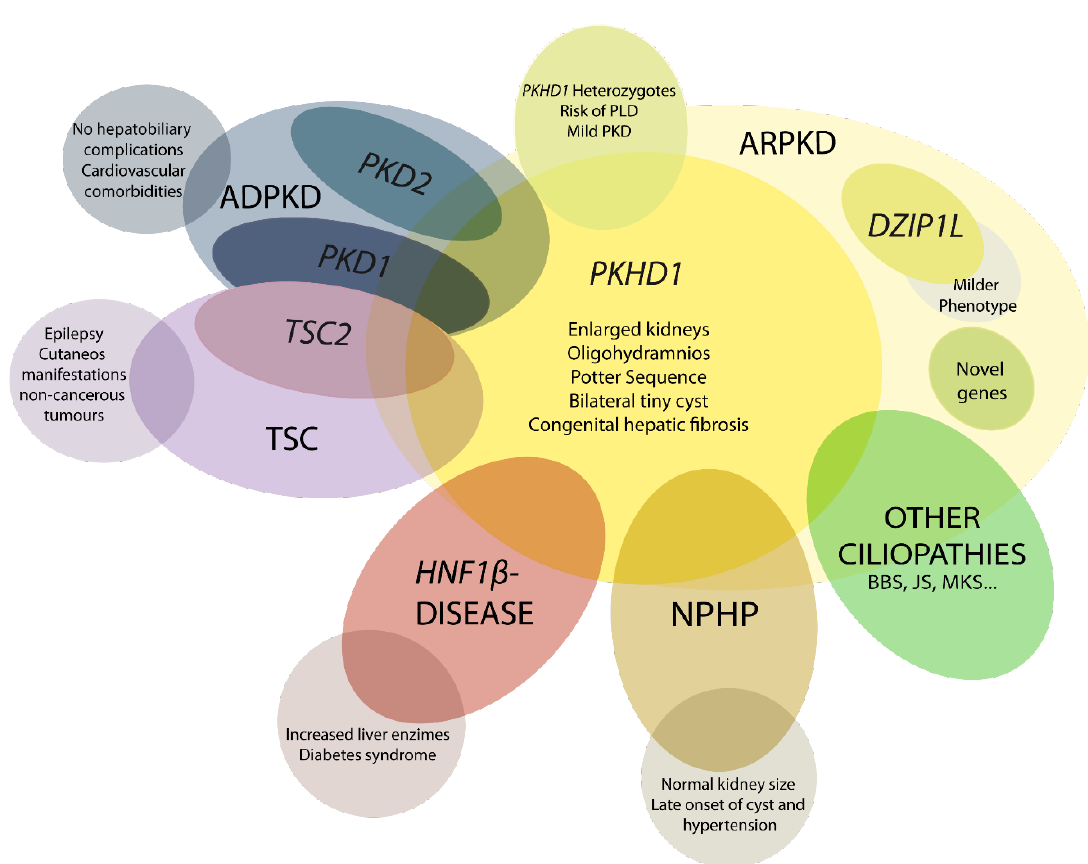
Figure 1. Schematic representation of ARPKD differential diagnosis. PHKD1 is the main causative gene in ARPKD, where DZIP1L present milder phenotype. Mutations in other genes can overlap clinical manifestations of ARPKD, such as PKD1 and PKD2 , the main causative genes of autosomal dominant polycystic kidney disease (ADPKD); TSC2, that causes tuberous sclerosis (TSC); and others for instance HNF1β , nephronophthisis (NPHP) genes and other ciliopathies as Bardet – Biedl (BBS), Joubert (JS), and Meckel syndrome (MKS). These overlapping phenotypes manifest the physiologic complex and functional interactions that occur among ciliopathy genes.